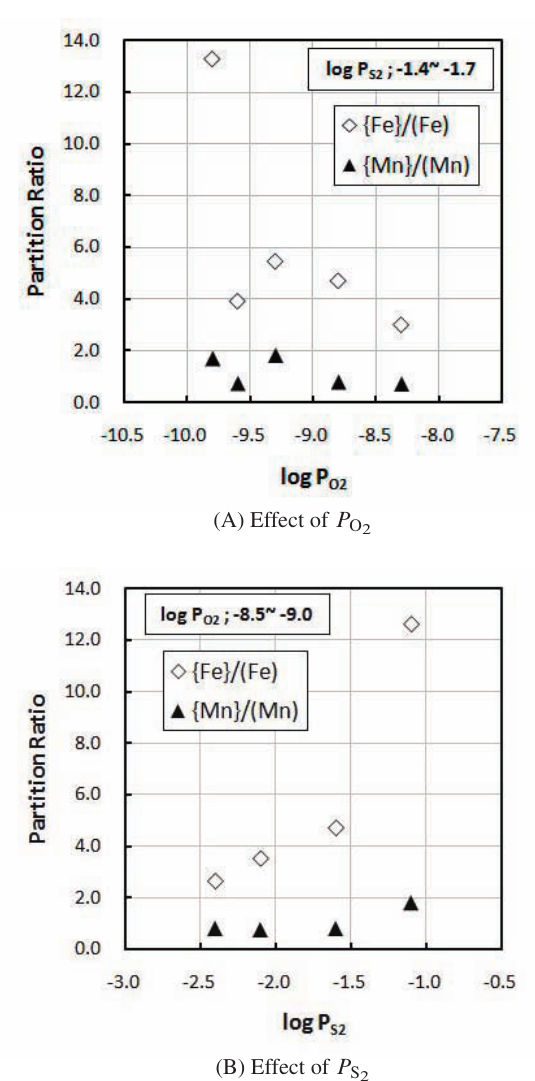
or P S on the partition ratios of 2 2